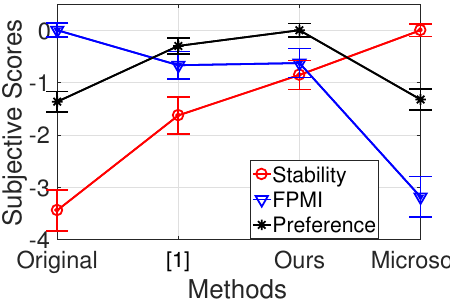
Figure 16. Result comparison of different version